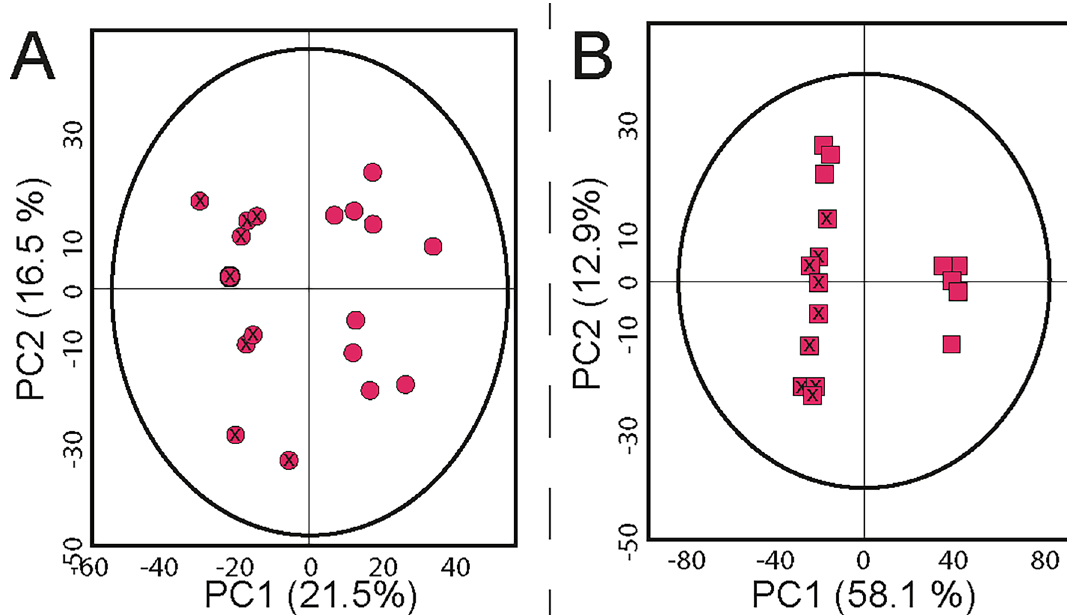
Figure 8. Principal component analysis of the untargeted metabolomic tests for less-polar/apolar metabolites of femora, comparing an affected group with a control group using cortical and trabecular samples from human osteoarchaeological remains in a C18 column and a nanoflow-UHPLC-Orbitrap-HRMS ESI positive mode platform. ( A ) Cortical bone R 2 (cum):0.603, Q 2 (cum):0.212, N = 18, 1780 variables; ( B ) trabecular bone R 2 (cum):0.71, Q 2 (cum):0.64. N = 18, 1623. X-Dots represent affected individuals in cortical bone. Dots represent individuals from the control group in cortical bone. X-squares represent affected individuals in trabecular bone. Squares represent individuals from the control group in trabecular bone. Ellipses indicate 95% of confidence for the PCA model. The explained variances of selected principal components are shown in